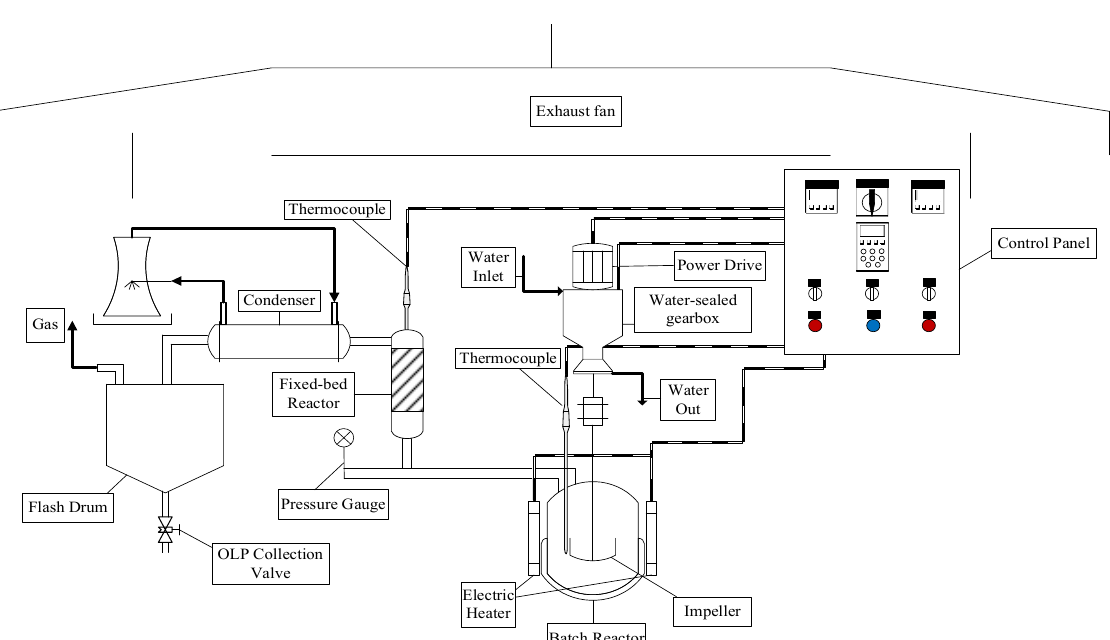
Figure 4. Thermal catalytic cracking unit with a pyrolysis reactor (R-1) and a fixed-bed reactor (R-2) in bench scale.